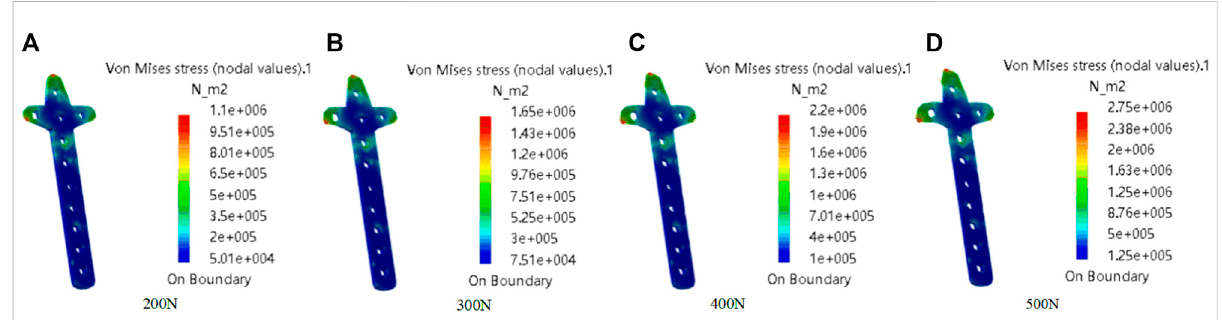
FIGURE 13 Mechanicalpropertyanalysisofcloverboneplate.Thedistributedforcewasappliedtotheupperofthemodel.From (A – D) ,theforcevaluesare 200N, 300N, 400N, and 500N.